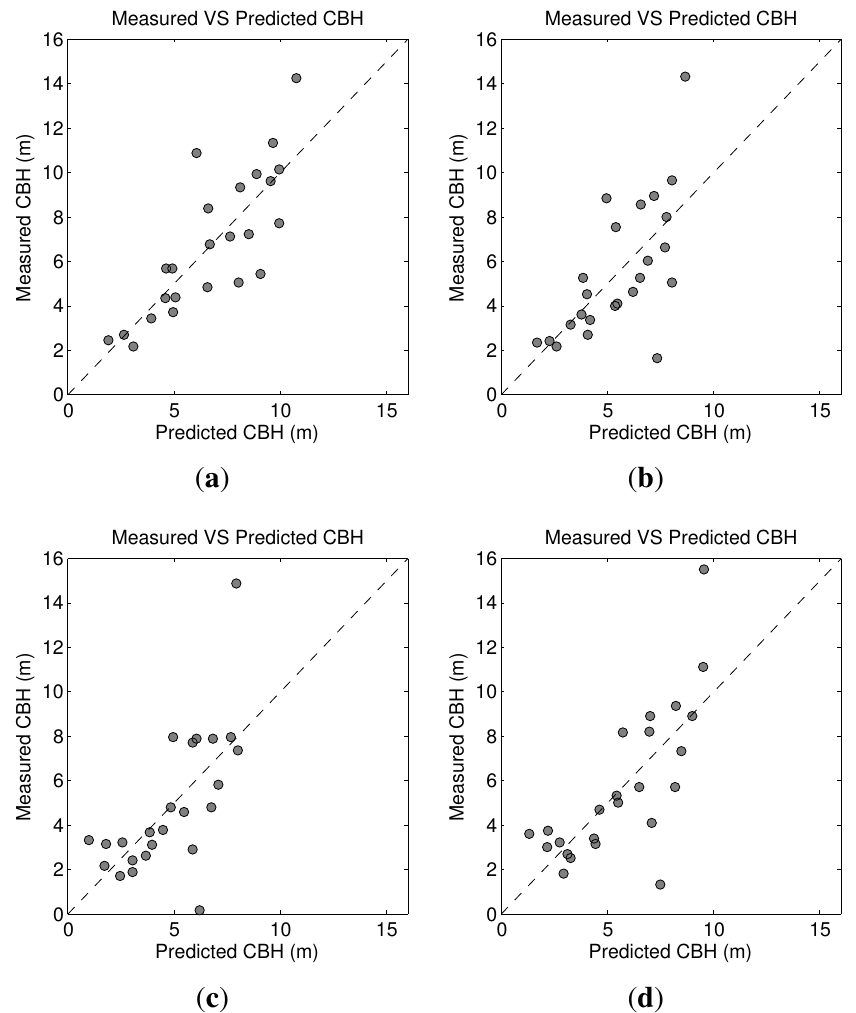
Figure 12. Plots showing a comparison between measured and estimated CBH for traditional percentile LiDAR metrics: ( a ) LOR; ( b ) AVG; ( c ) P40; ( d ) P50. The diagonal line shows a 1:1